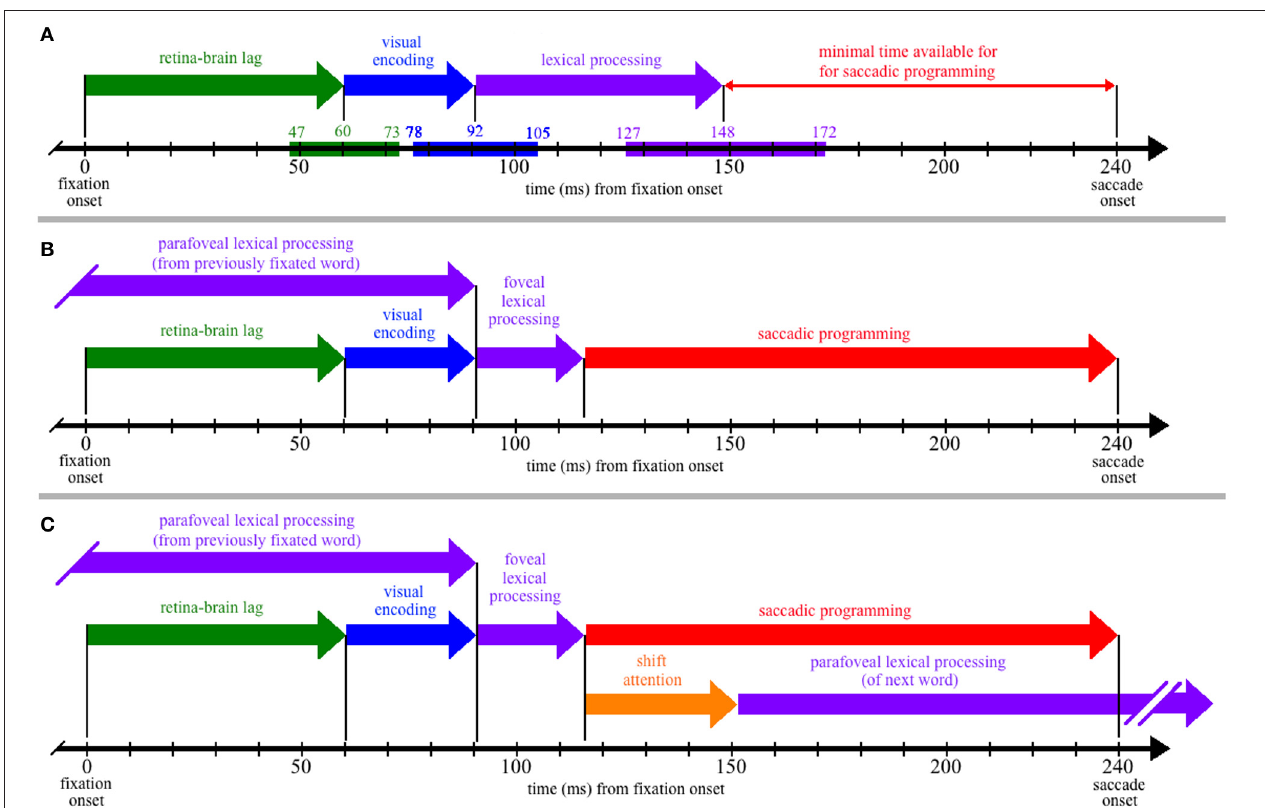
FIGURE 1 | The time course of processing during a single, 240-ms fixation on a word, including: (1) the propagation of information from the retina to brain (green); (2) visual encoding of the word features (blue); (3) lexical processing (purple); (4) saccadic programming (red); and (5) shifting attention from one word to the next (orange). (Panel A ) Neurophysiological estimates for the times required for the retina-brain lag, visual encoding, and lexical processing are indicated by the colored bars superimposed on the time line that is shown at the bottom of the panel, with the three numbers above each colored bar indicating the estimated minimum, mean, and maximal times to complete each respective process (e.g., the estimated minimal time needed for the retina-brain lag is 43ms). Based on these estimates, there should be little time (92ms) available for saccadic programming and whatever transmission delays are necessary, e.g., to transmit a signal about the state of lexical processing to the oculomotor system. (Panel B ) If some amount of lexical processing of the fixated word is actually completed parafoveally, from the previously fixated word, then the amount of (foveal)